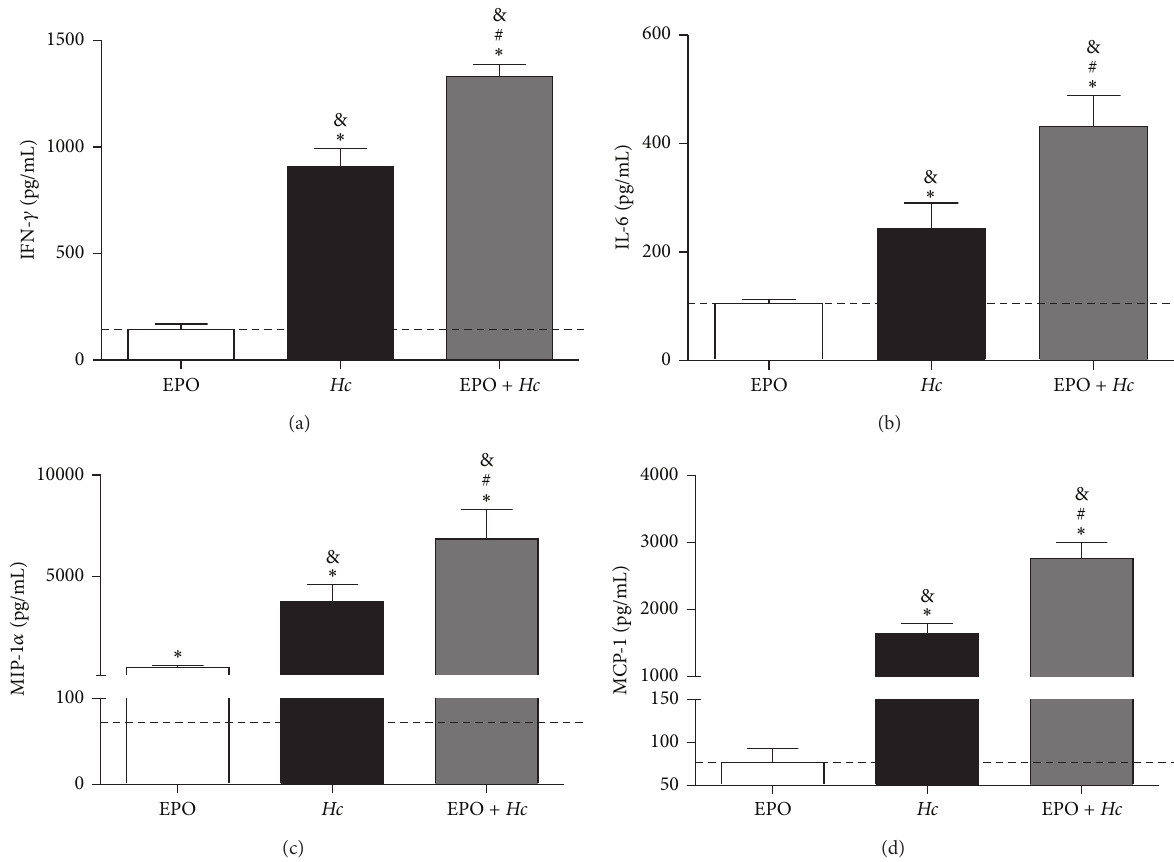
Figure 5: EPO pretreatment increases proinflammatory cytokines and chemokines in lungs from Hc -infected mice. Lungs were removed from uninfected mice treated with 45U EPO (EPO) or from untreated ( Hc ) or EPO pretreated ( EPO + Hc ) mice infected with Hc (5 × 10 5 yeasts/100 𝜇 L/mouse). Lungs were removed 14 days after infection and homogenized, and the concentrations of IFN- 𝛾 (a), IL-6 (b), MIP- 1 𝛼 (c), and MCP-1 (d) were assessed in the supernatants using ELISA. Means ± SEM values from one representative experiment of two independent experiments are shown ( 𝑛 = 4 –6). Newman-Keuls multiple comparison test was used and the differences were considered significant when 𝑝 < 0.05 . # Versus Hc ; ∗ versus uninfected and EPO-untreated (dashed line); & versus uninfected and EPO-treated mice.